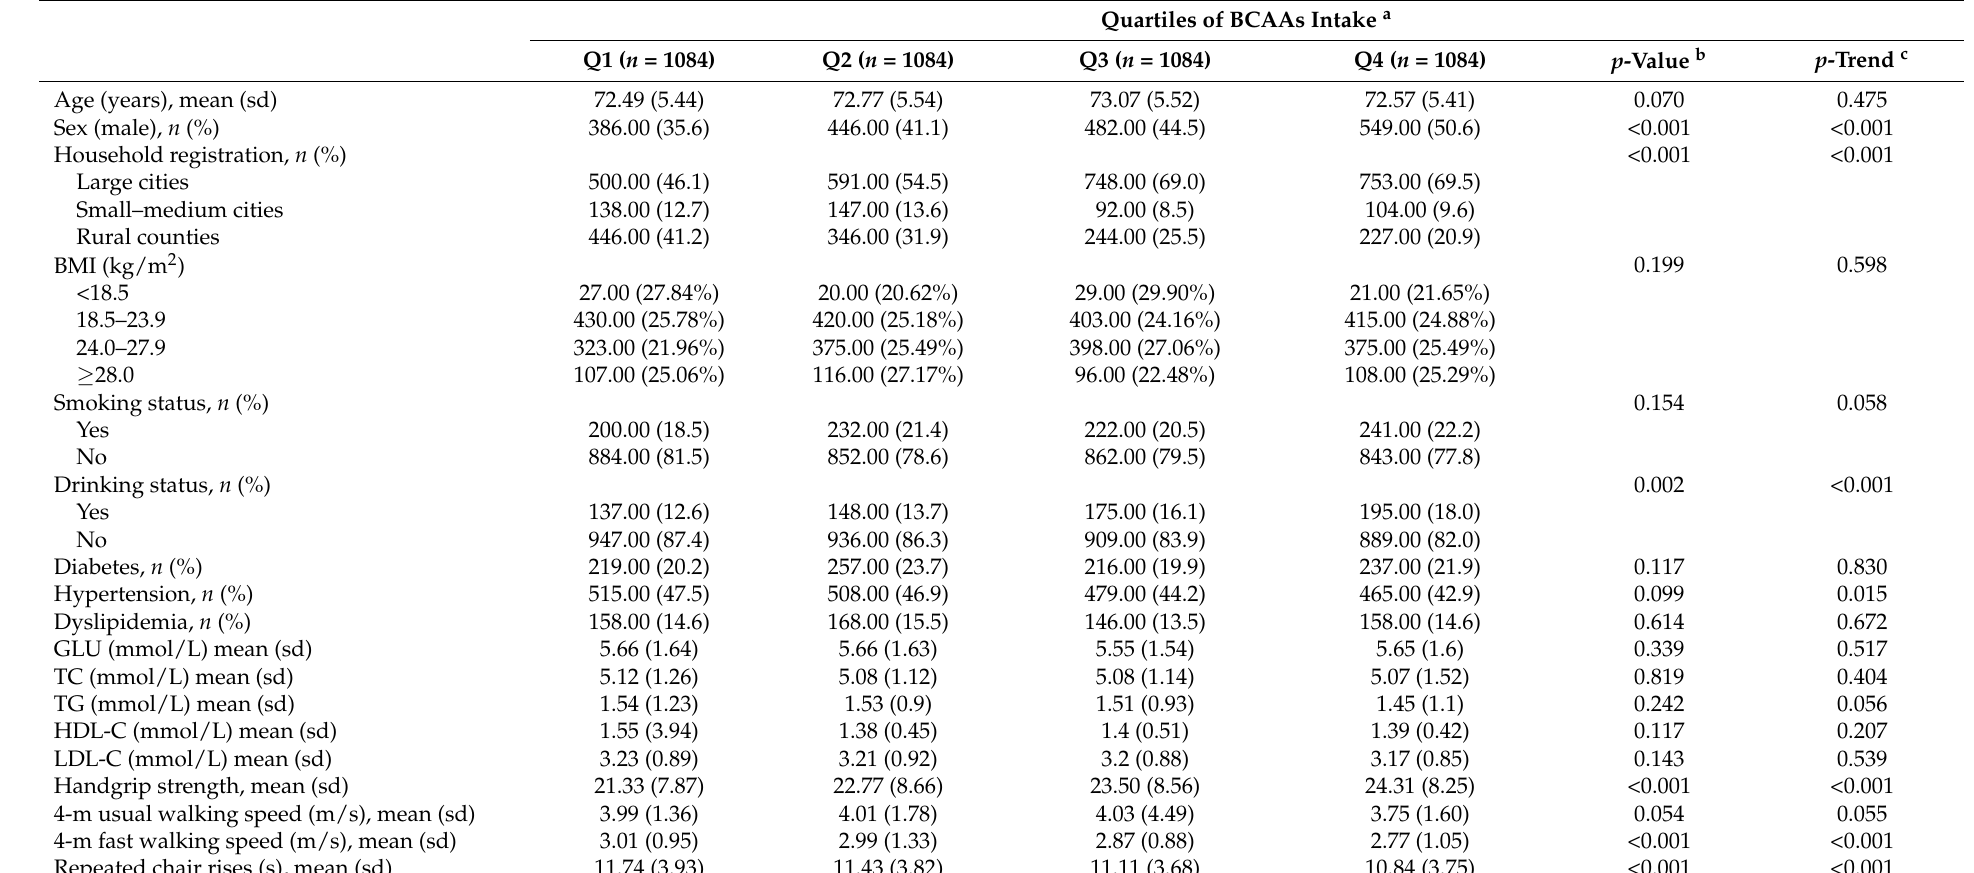
Table 1. Descriptive characteristics of study participants by quartiles of total BCAAs intake ( n =